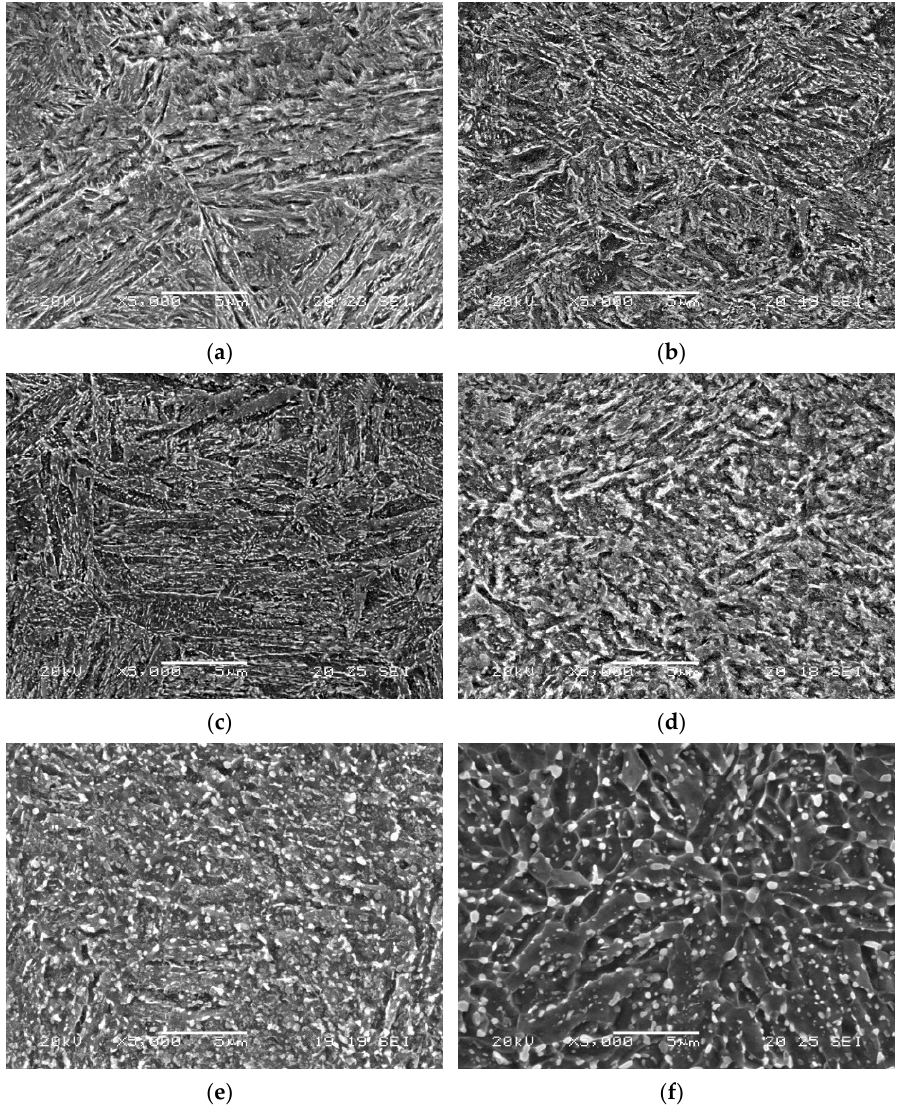
Figure 3. Microstructures (SEM, 5000×) of Q + T 42CrMo4 steel grades. ( a ) QT300-3min, ( b ) QT600-